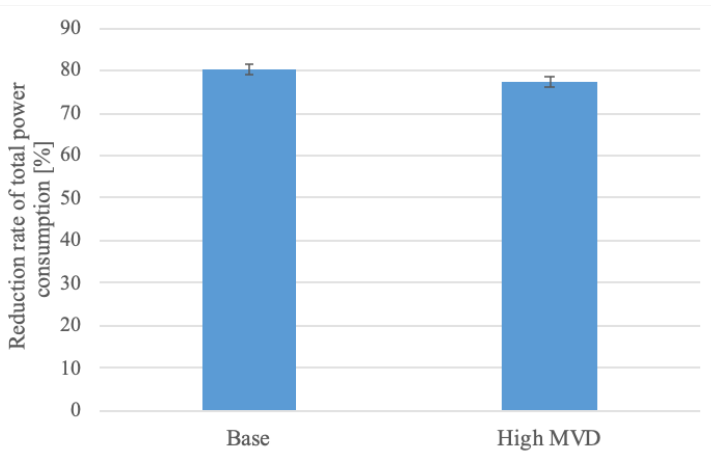
Figure 10. The reduction in the power consumption calculated by Equation (2) by the ICE-WIPS for the validation tests.